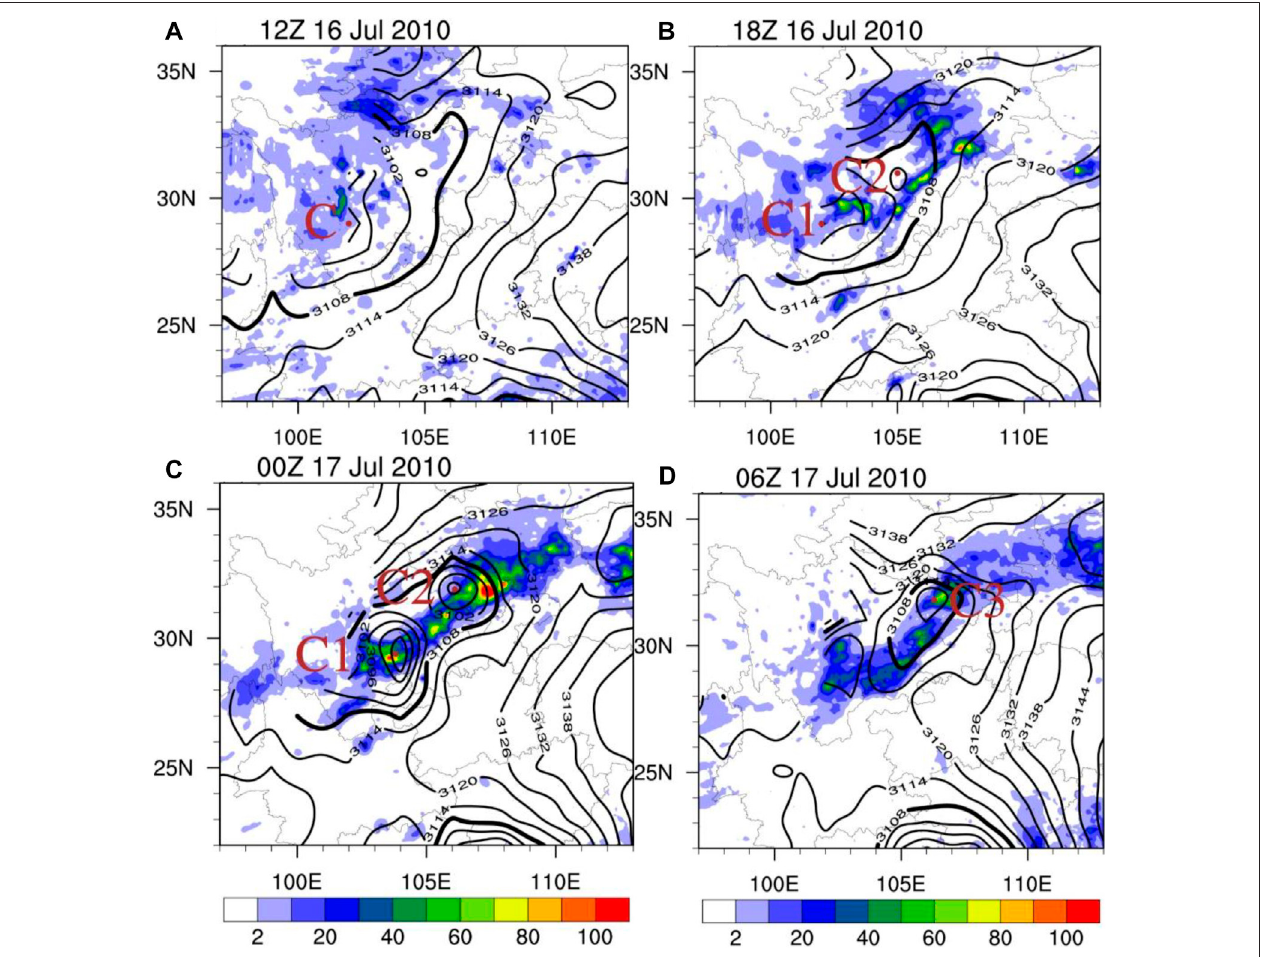
FIGURE3| Spatialdistributionsofthe700hPageopotentialheight(gpm,contours)andthepre-6-haccumulatedprecipitation(mm,shaded)at (A) 12:00UTCJuly 16, (B) 18:00 UTC July 16, (C) 00:00 UTC July 17, and (D) 06:00 UTC July 17.